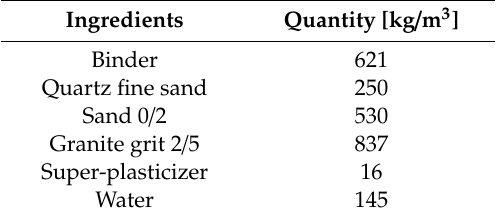
Table A2. Composition of the concrete (values according to